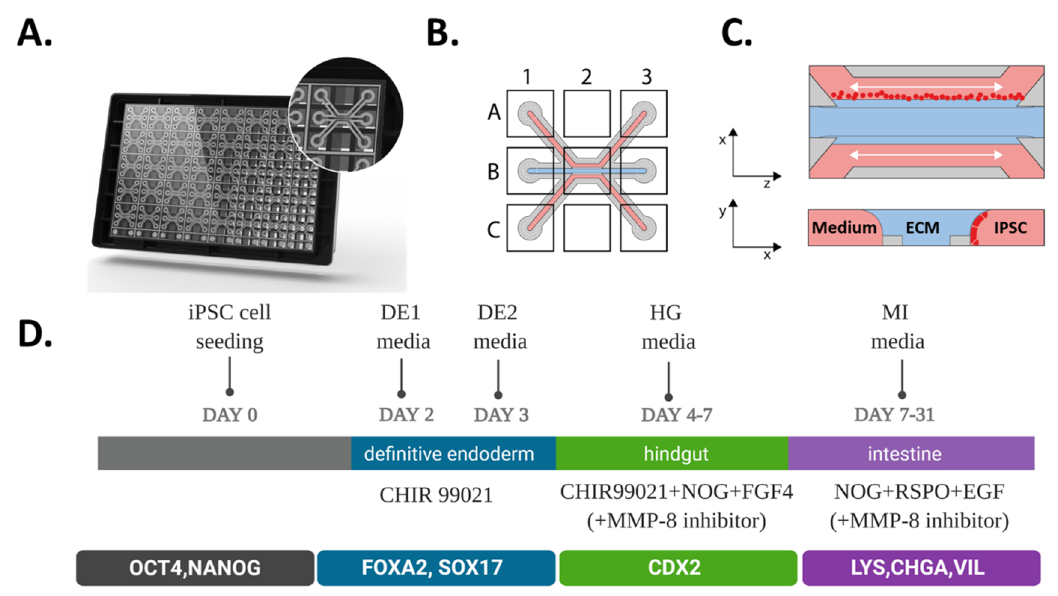
Figure 1. Seeding and differentiation of hiPSC in the 3-lane OrganoPlate. ( A ) Artist’s impression of the bottom-side of the 3-lane OrganoPlate containing 40 individual microfluidic chips. The inlay shows an individual chip that is communicating with nine connecting wells. ( B ) Scheme of a single chip containing three microfluidic channels all having top, middle and bottom inlets (A1, B1 and C1), outlets (A3, B3 and C3) and an observation window (B2). ( C ) A schematic representation of hiPSC introduction to a microfluidic chip in a top (xz plane) and cross sectional view (yz plane); single iPSCs (in red) are seeded in the top channel and are allowed to adhere for up to 24 h after which media is added and perfusion initiated, cells start to form tubules by first growing against the ECM gel (blue) and then covering the whole channel. ( D ) Schematic of workflow for directed on plate differentiation of iPSC towards gut tubules.